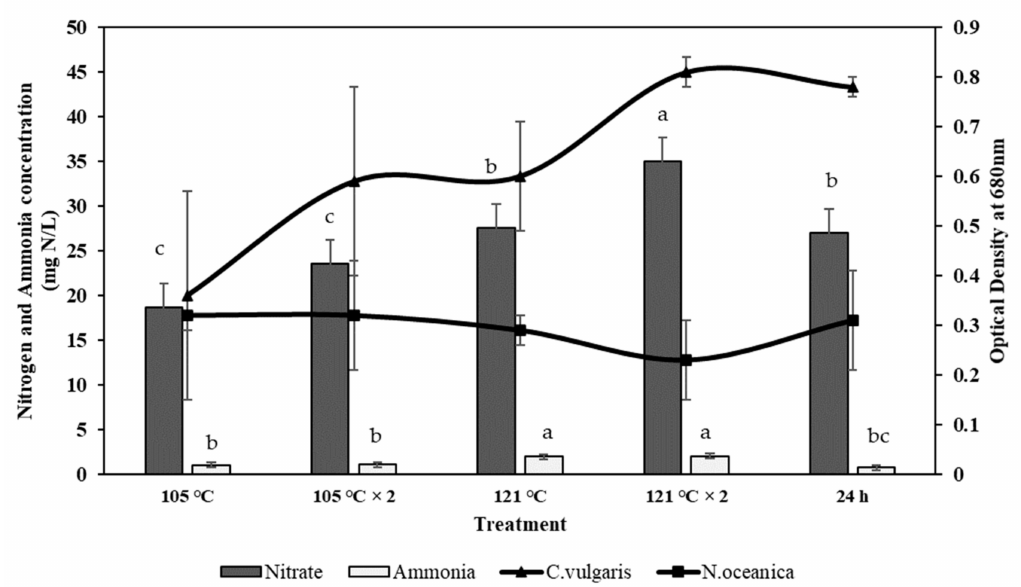
Figure 4. Effect of ammonia and nitrate concentration in on the growth of C. vulgaris and N. oceanica from Raja Musa Forest Reserve (RMFR) with different extraction methods. (105 ◦ C—autoclave 105 ◦ C; 105 ◦ C × 2—autoclave 105 ◦ C 2 × after natural extraction 24 h; 121 ◦ C—autoclave 121 ◦ C after natural extraction 24 h; 121 ◦ C × 2—autoclave 121 ◦ C twice after natural extraction 24 h; 24 h—natural extraction for 24 h). Error bars represent standard deviation ( n = 3). a–c Mean value with different superscripts are significant different ( p < 0.05) using ANOVA and Turkey post-hoc.